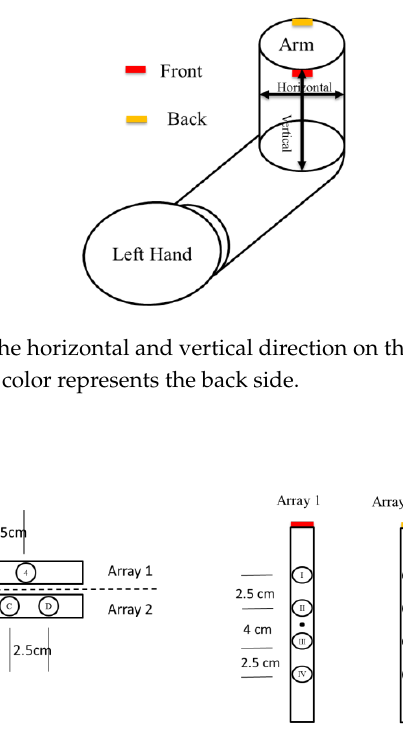
Figure 3. Two different sizes for the electrode array in two directions. ( a ) There are four electrodes in one array in the horizontal direction; ( b ) There are eight electrodes in one array in the vertical direction. Four electrodes are on the front side. The other four electrodes are on the back side.